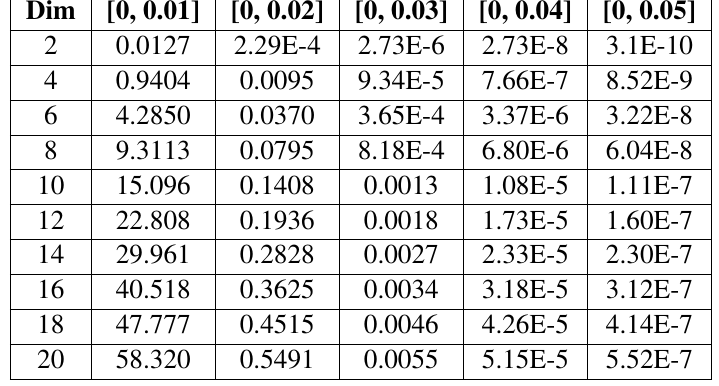
Table 2: Results on the modified Sphere function from 2 dimensions to 20 dimensions